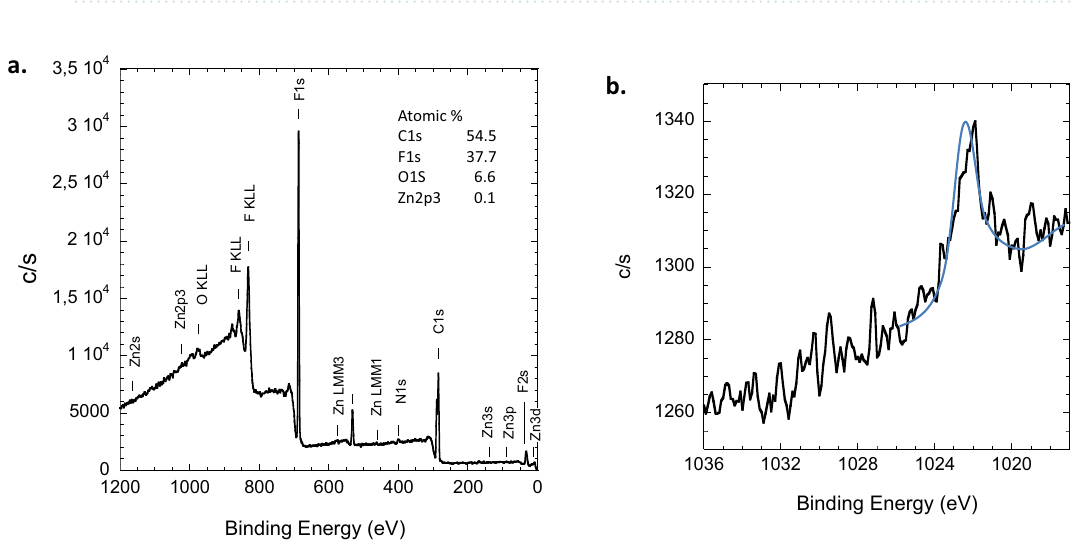
1 Zn(II) spiked deionized water